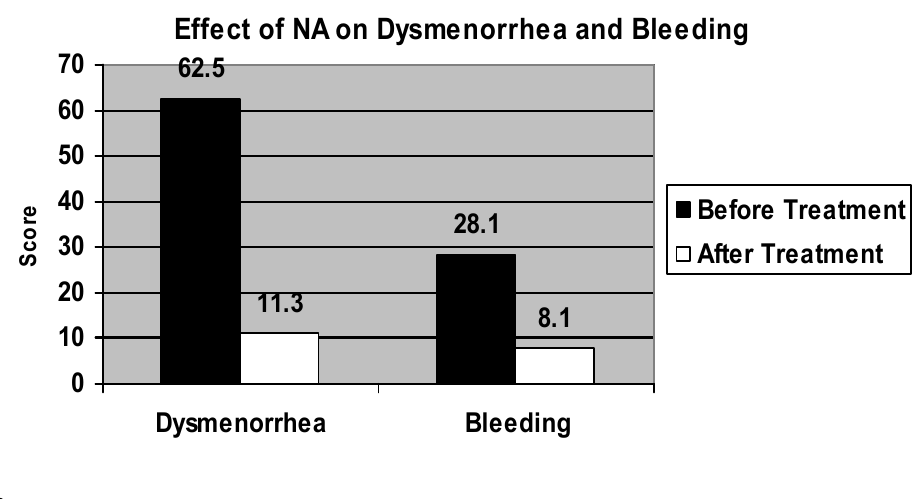
Figure 1. Dysmenorrhea score calculated by multiplying each day’s scores by total number of days of bleeding. Bleeding score calculated by adding the individual day’s